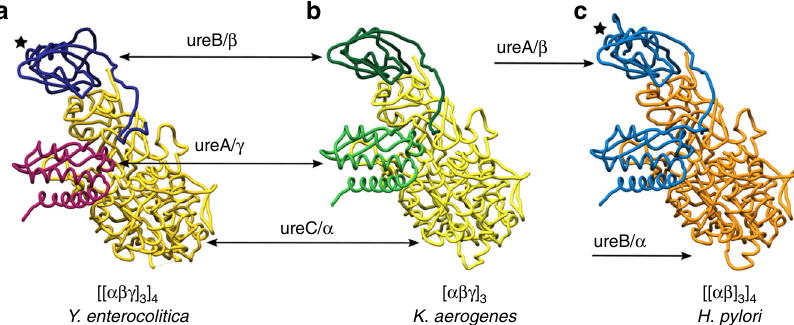
Fig. 3 Comparison of Y. enterocolitica urease chain architecture with ureases with different modes of assembly from other pathogens. Hetero-trimers are shown in tube representation with each chain in the same colors of the sequences in Fig. 1b. The black star indicates the central helix of the β subunit. The Y. enterocolitica and H. pylori ureases form the same dodecameric assembly despite having different types of chain splitting, while K. aerogenes urease has the same type of chain splitting as in Y. enterocolitica but forms only a trimeric assembly.